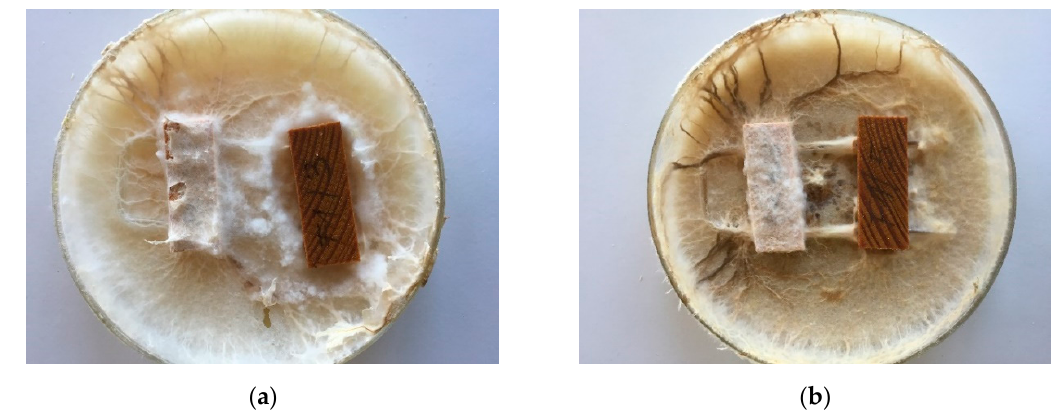
Figure 1. Scots pine wood after exposure to C. puteana : ( a ) control wood sample and wood treated with 18.9% propolis extract; ( b ) control wood sample and wood treated with 30% propolis extract.